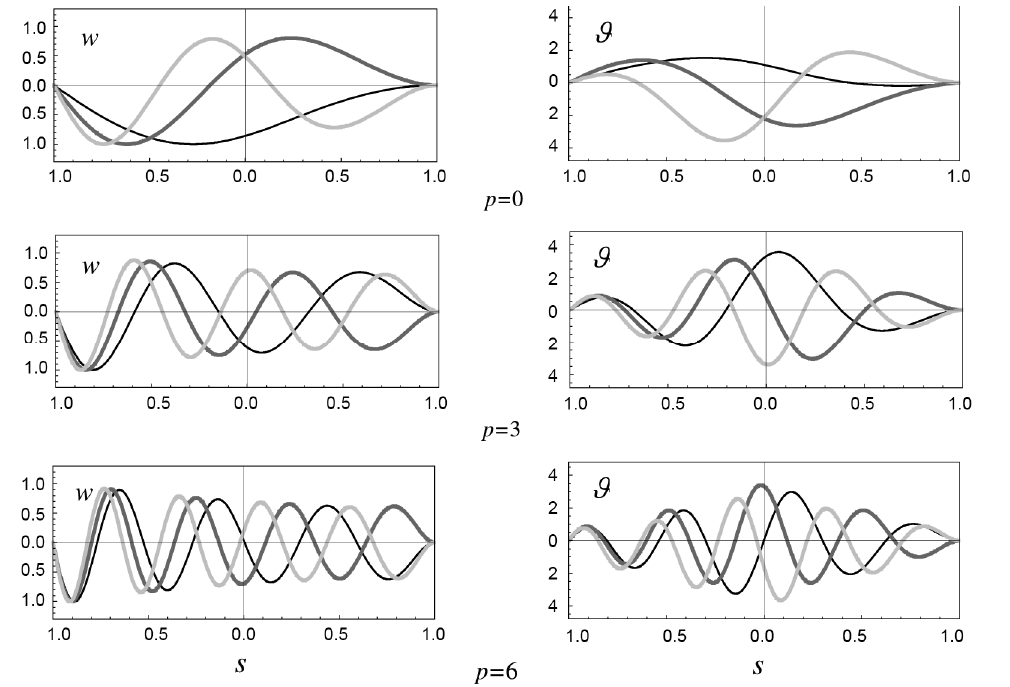
Fig. 4. Diagrams of eigenforms for H-C Catenary arch Form denotations: p